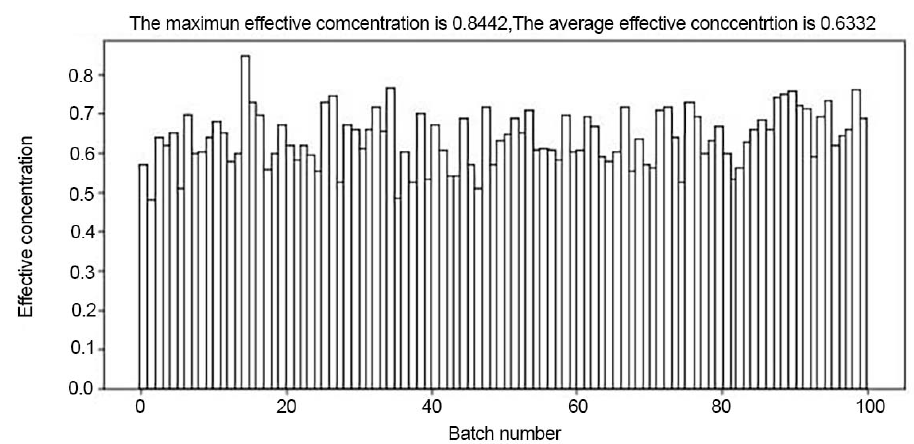
Figure 9. Histogram of batch number and effective concentration.